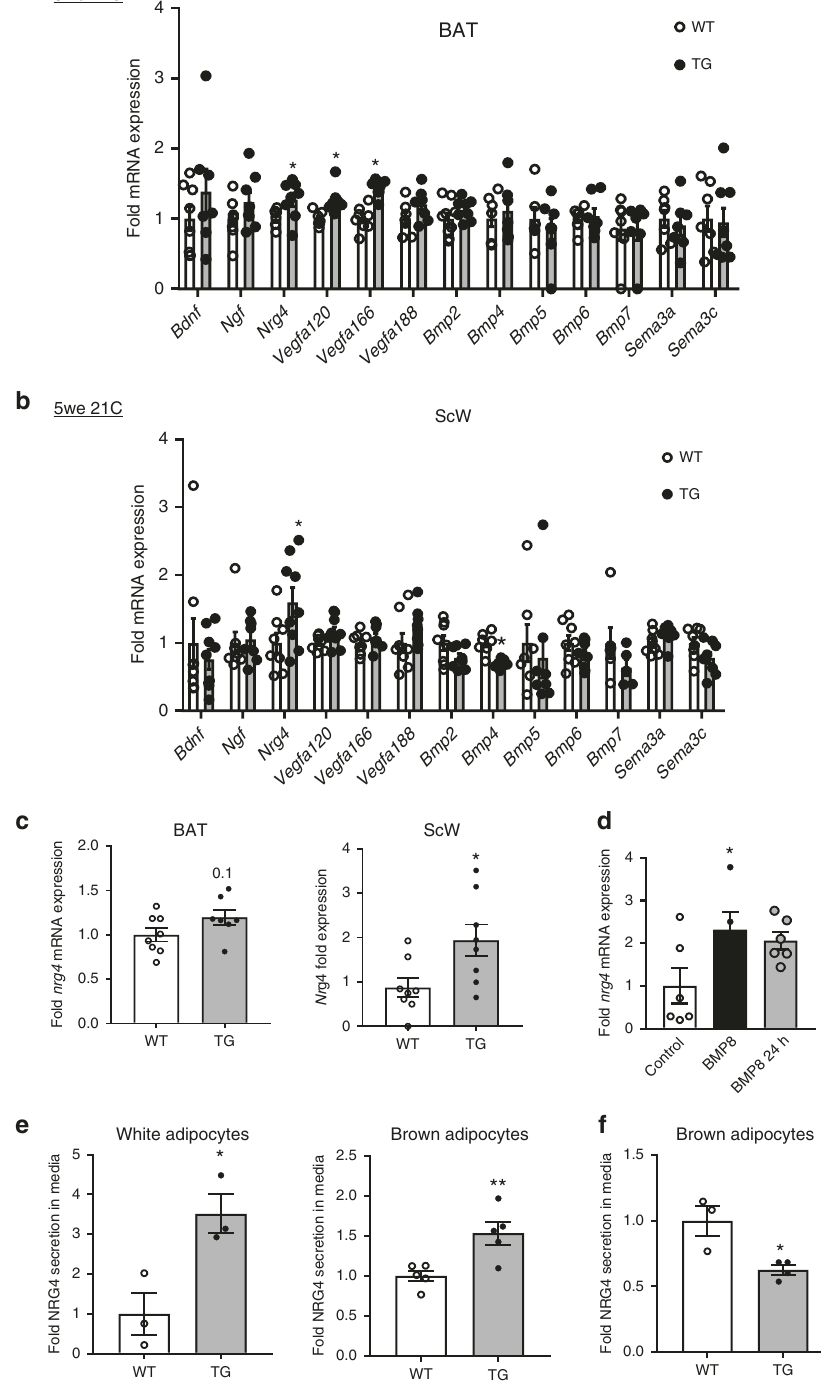
Fig. 3 BMP8b-dependent regulation of NRG4 in AT and adipocytes. a , b Fold variation of mRNA levels of molecules that regulate sympathetic neuron survival, or axonal or dendritic guidance or growth in BAT ( a ) and ScW ( b ) from 5-week-old WT and Bmp8b TG female mice; n = 8 – 9. c NRG 4 mRNA levels in BAT and ScW from 4-week-old WT and TG female mice born and housed at 28 °C, n = 7 – 8. Data are represented normalized to the WT value; * p < 0.05 compared to WT using Student ’ s t -test ( e – h ). d Fold variation of NRG4 mRNA levels in differentiated brown adipocytes chronically (9 days, during differentiation) or acutely (24 h at day 8 of differentiation) treated with human recombinant BMP8 (red bar and pink bar, respectively). e – g ELISA analysis of NRG4 secretion of white unilocular (isolated from ScW) ( e ) and primary brown differentiated adipocytes (isolated from BAT) from 10-week-old Bmp8b TG versus WT ( e , f ) and Bmp8b + / + versus Bmp8b – / – ( g ) mice; n = 3 – 5. Mean ± s.e.m. are presented; * p < 0.05, compared to WT using multiple t -test with FDR determined using the two-stage linear step-up procedure of Benjamini, Krieger and Yekutieli ( a , b ); * p < 0.05, ** p <0.01 compared to WT using Mann – Whitney test ( c, e, f ); * p < 0.05, one-way ANOVA compared to control with Sidak ’ s post-hoc multiple comparisons test ( d